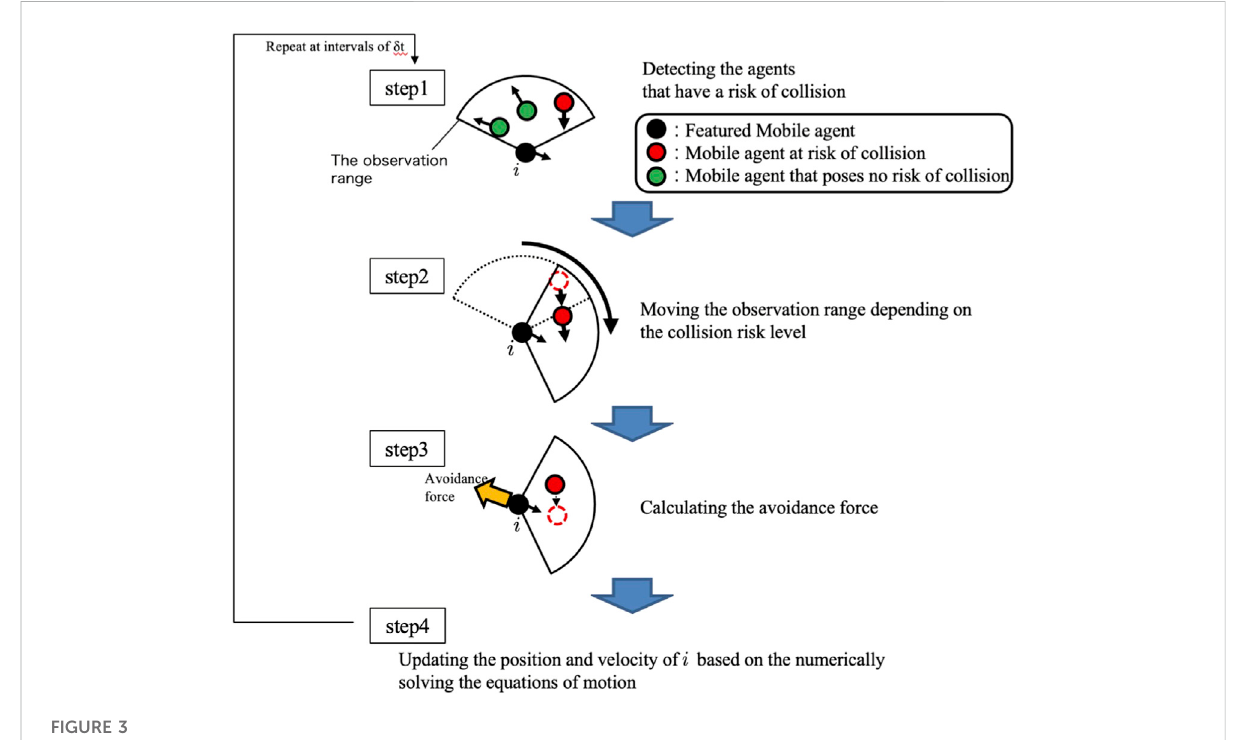
FIGURE 3 Flow of the algorithm for the proposed